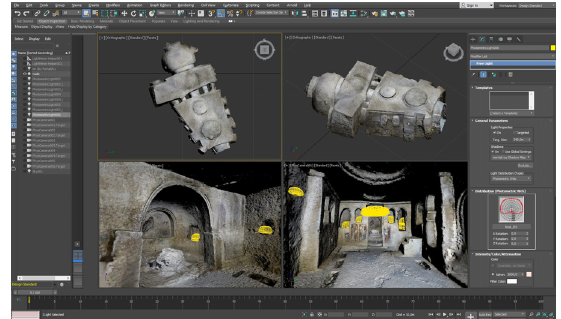
Figure 5: Sw 3D Studio Max. Hypothesis of artificial